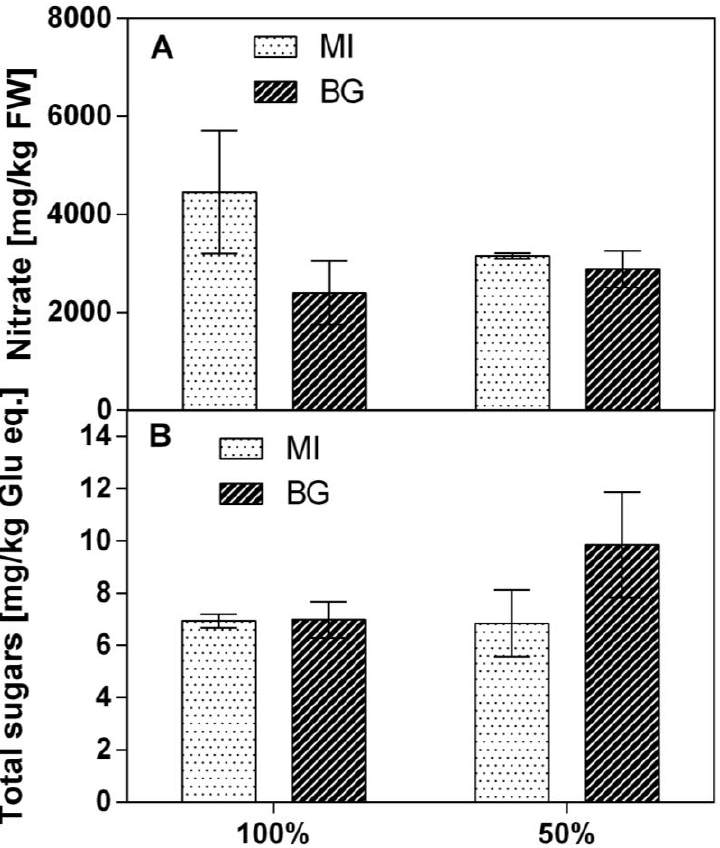
Figure 2. Nitrate ( A ) and total sugar ( B ) content in fresh leaves of two wild hedge mustard popu- lations, MI and BG, cultivated under different water availability levels (100% and 50%). Values are means with standard errors (n = 3). Data were subjected to two-way ANOVA, and no significant differences were found.